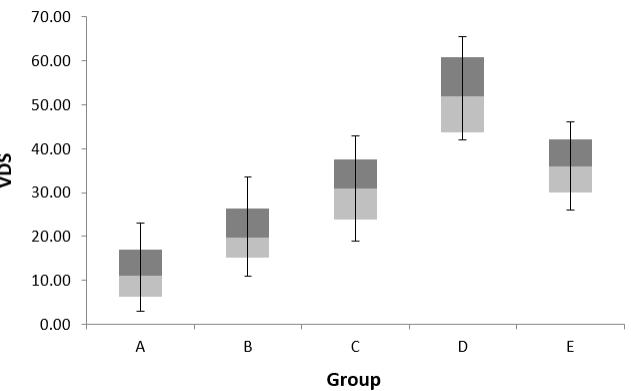
Figure 3. Comparison of values of videofluoroscopic dysphagia scale in each group.